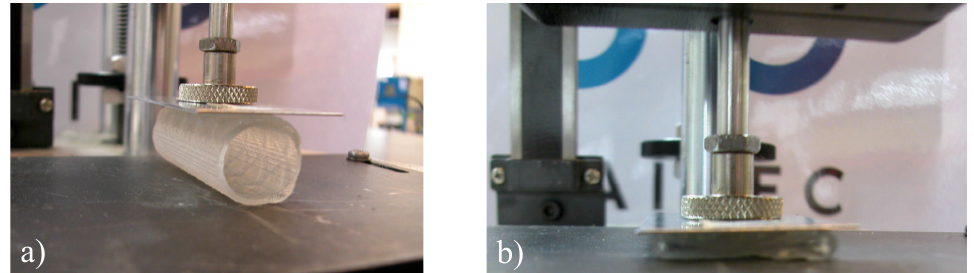
Figure 4. Flat plate experimental testing: ( a ) unloaded and ( b ) crushed